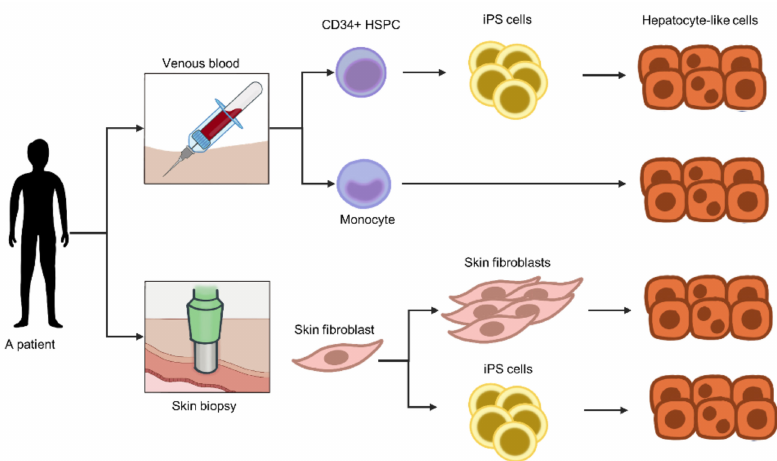
Figure 3. Sources of patient-specific hepatocytes. For an individualized liver-on-a-chip, the target cells must be obtained from patients. Evidence suggests the possibility of transdifferentiating monocytes or fibroblasts into hepatocyte-like cells. Due to their limited cell proliferation capability, these cells must be induced to differentiate into pluripotent stem cells that proliferate indefinitely. Thus, iPS cells provide a scalable assay if needed. Given the low invasiveness of sample collection, blood cells are promising targets for hepatocyte generation. Abbreviations: HSPCs, hematopoietic stem and progenitor